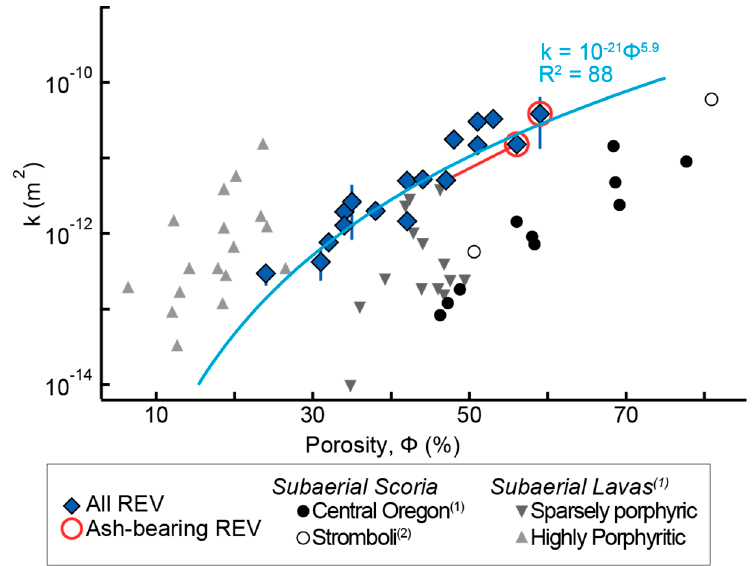
Figure 8. Permeability (k) versus porosity (in this figure, ϕ ). Blue diamonds are analysed subvolumes from [32] and used for this work. Ash-bearing subvolumes indicated by red circles. Red line connects the ash-free and ash-bearing subvolumes from within the same clast (SY-10; Table 1). Vertical error bars show maximum variability in x, y, and z directions, and are usually smaller than symbol size. Published data of subaerial scoria and basaltic lavas are shown for reference. 1 [104], 2 [105,106].